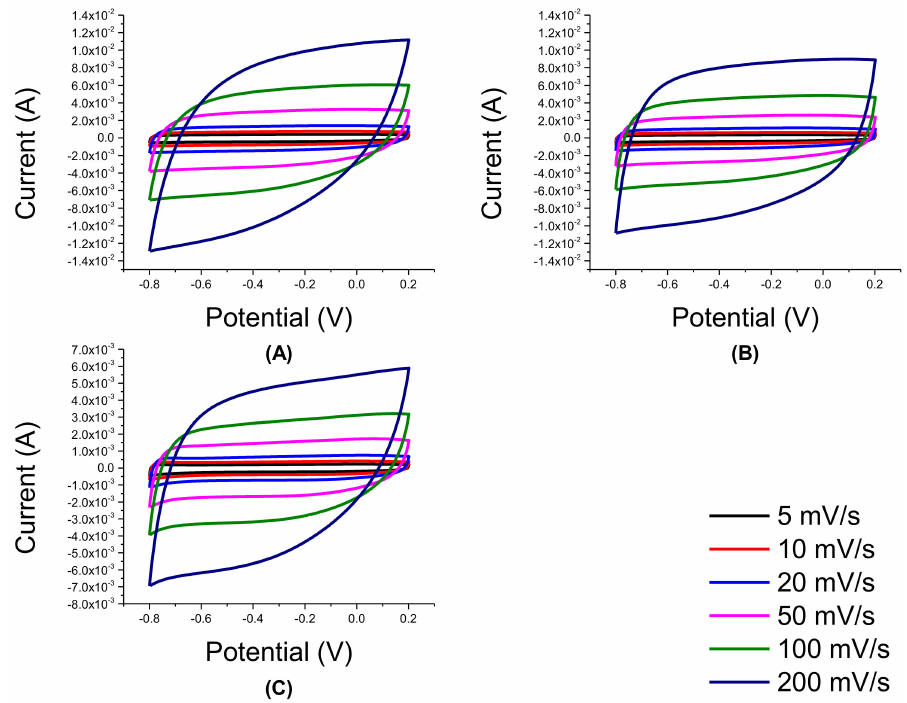
Figure 8. CV of rGO/TiO 2 : ( A ) 3:1, ( B ) 1:1, and ( C )